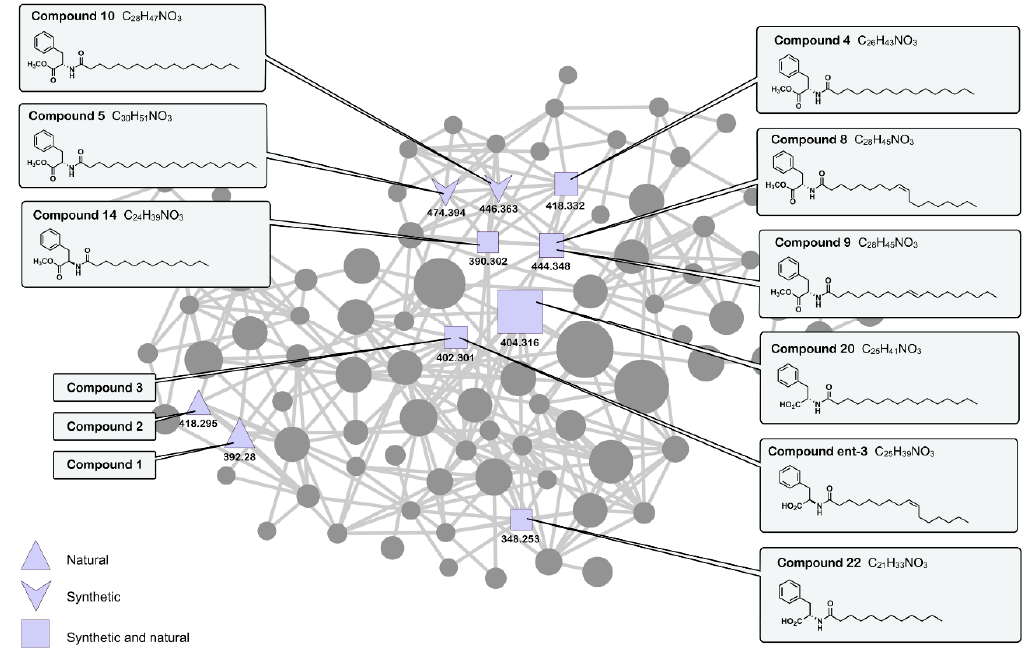
Figure 4. Cluster corresponding to natural lipoamino acids in the ethyl acetate extract of the Pantoea species together with synthetic lipoamino acid derivatives. The size of the nodes is proportional to the peak height of each feature within the Pantoea sp. extract.